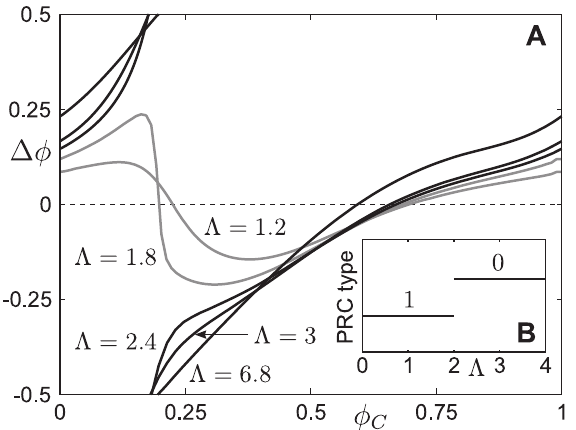
Figure 6. Determining phase information from experimental stress-response data. (A–B) Illustration of how peaks are selected in order to compute the phase information from experimental stress- response data. The time histories show levels of CORT sampled at 10 min intervals in exemplar female Sprague-Dawley (A) and female Lewis (B) rats. Shaded region indicates the period of the applied noise stress. Selected peaks ( p ) are marked red.